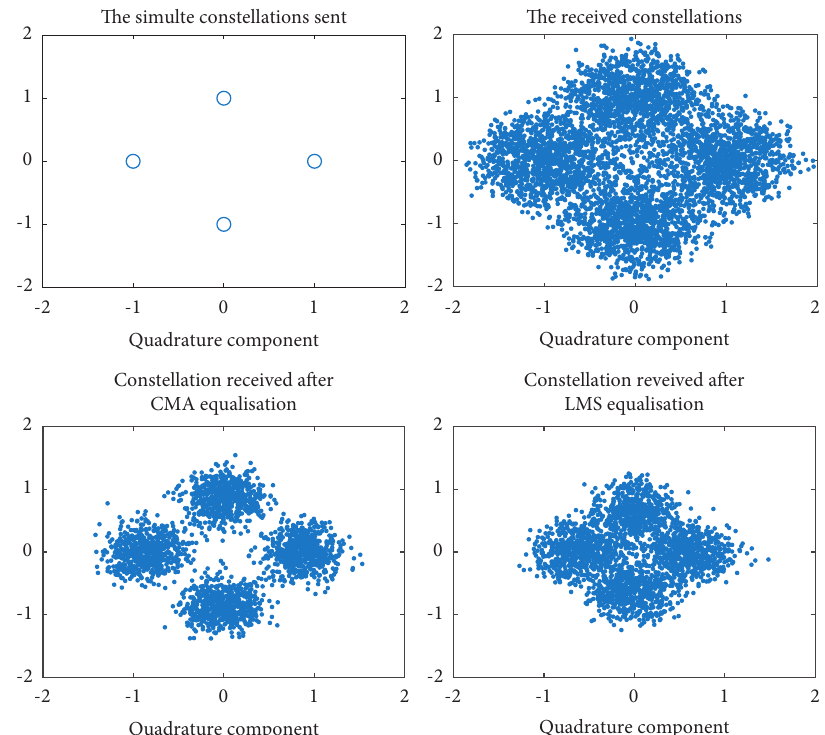
Figure 3: QPSK modulations equalised by the CMA and LMS algorithm for a constellation comparison.